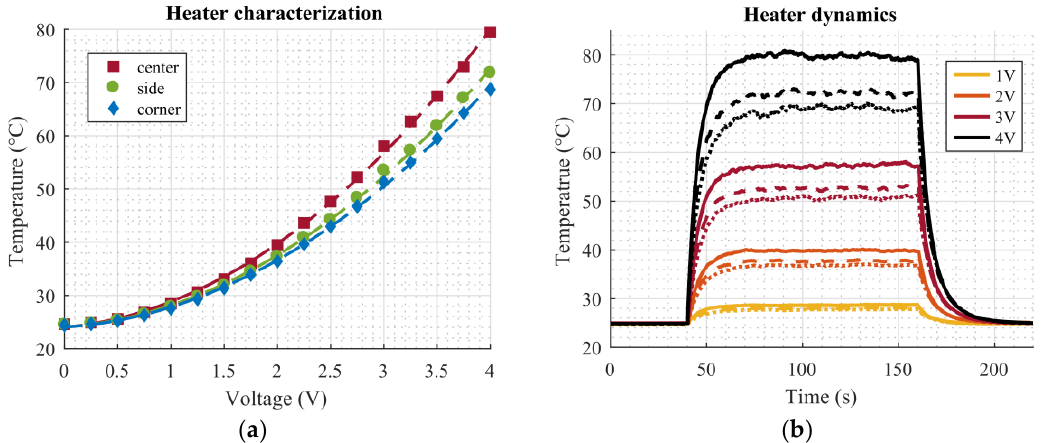
Figure 6. Microheater characterization. ( a ) Microheater characteristics. The markers show measurement points, the dashed lines corresponding quadratic fits. ( b ) Microheater dynamics for several voltage steps. Solid lines correspond to the center position, dashed lines to the side position, and dotted lines to the corner position. The voltage step for all measurements starts at 40 s and ends at 160 s.